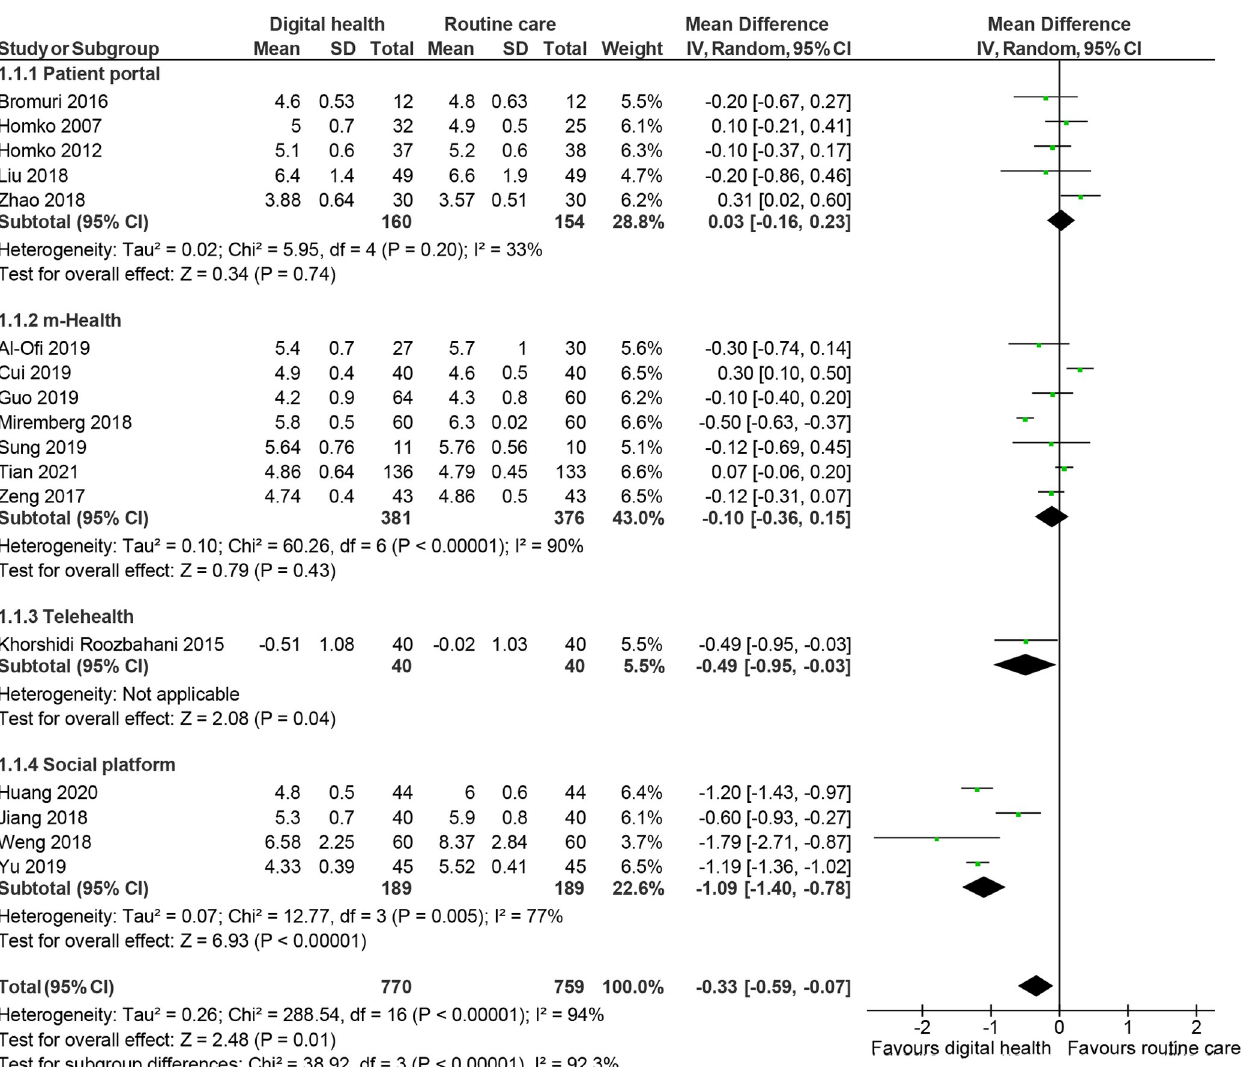
Fig 2. Random effects meta-analysis of the mean difference in fasting plasma glucose (mmol/L), comparing digital health or routine care.